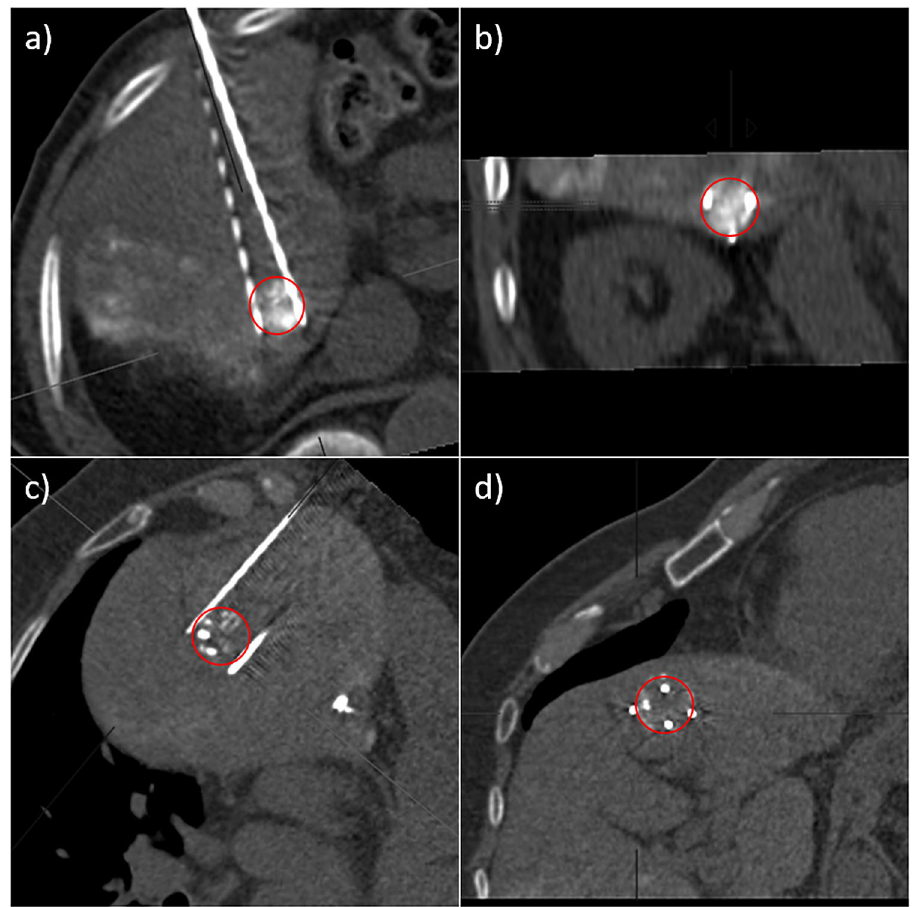
Figure 3. Example of two successful IREs with adequate needle placement. In each case MPRs of the CT with the needle positions immediately before ablation, in parallel alignment to the needle plane ( a , c ) and orthogonal to it ( b , d ) are shown. Both tumors were marked with Lipiodol the day before, lesions outlined in red. ( a ) and ( b ) Ablation with 3 needles. The three needles were placed adjacent to the tumour with a low tumor-center- to-ablation-center distance (TACD = 1 mm), with sufficient needle depth (Ndep = 0). Ablation was successful, although needle divergence was relatively high (average NDiv = 4.8°). ( c ) and ( d ) Ablation with 4 needles, a stereotactic navigation system was used for needle placement. Here, too, all needles were placed at sufficient depth (NDep = 2 mm) in the area around the edge of the tumor with a sufficiently low tumor-center-to-ablation- center distance (TACD = 5 mm) and almost no needle divergence (average NDiv =